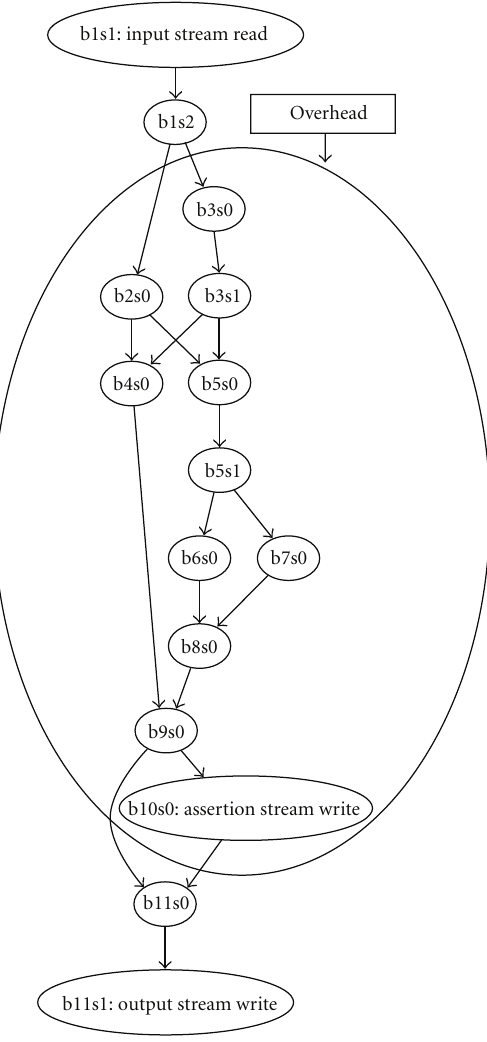
Figure 3: Application’s state machine with unoptimized, serial